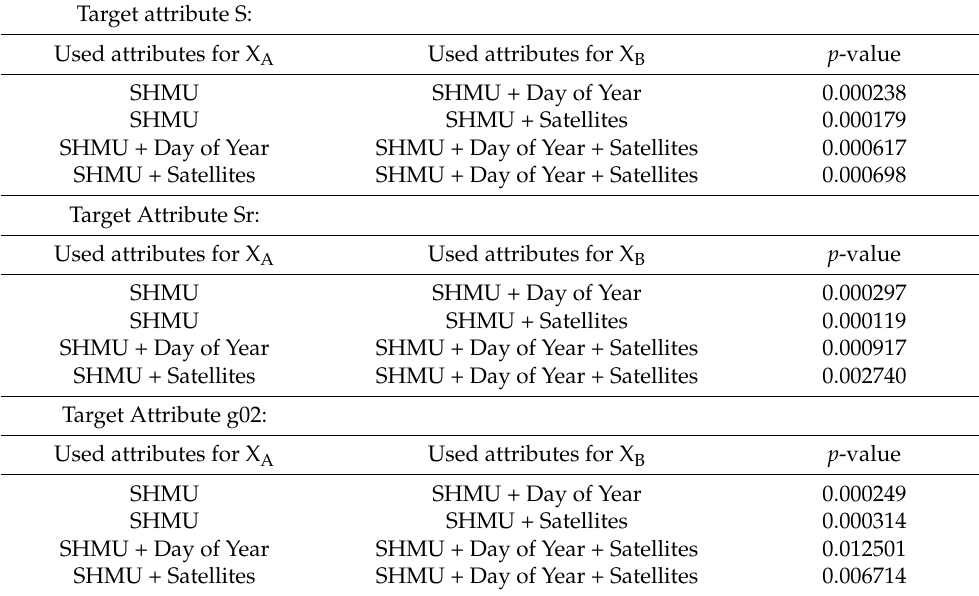
Table 5. Results of statistical permutation tests, which show that additional satellite-derived at- tributes and the measurement date have ensured a significant increase in the accuracy of trained regression